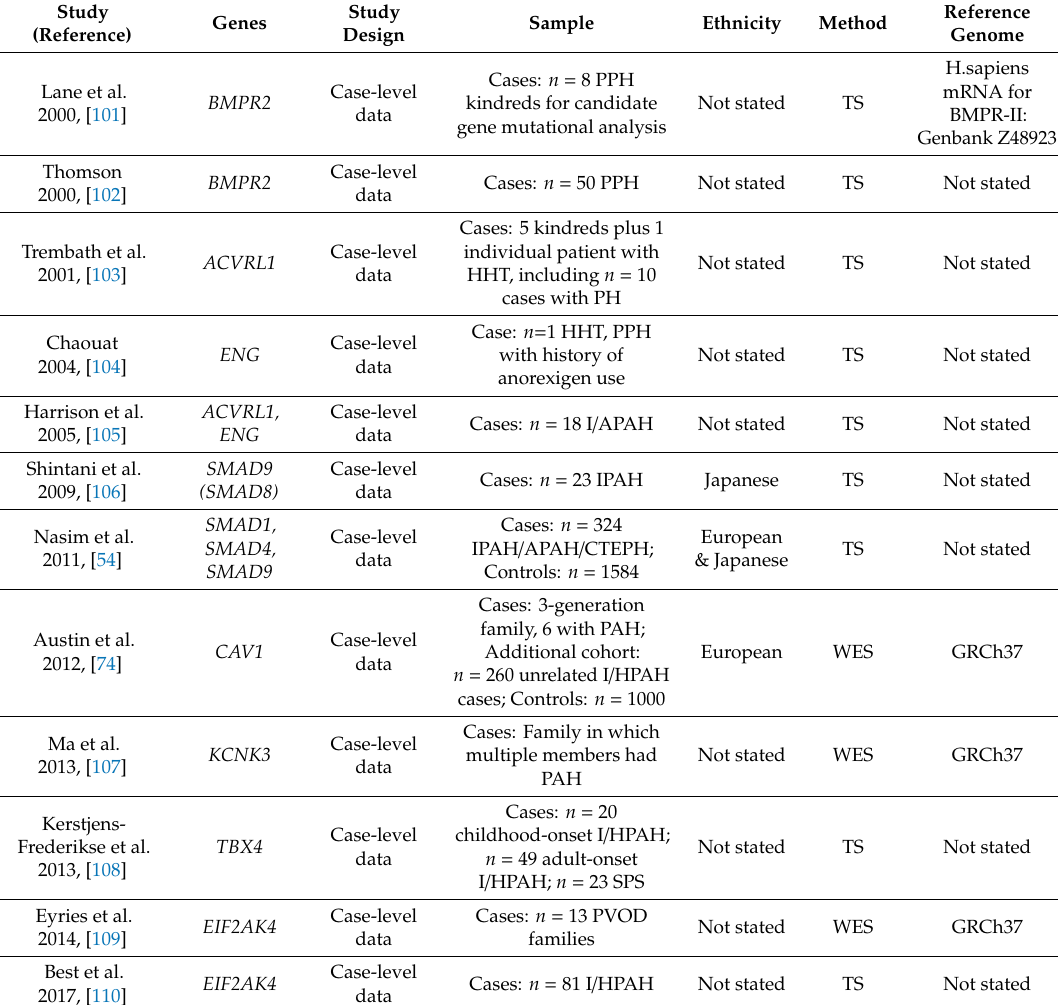
Table 2. Landmark forward genetics studies in Group 1 PAH. Abbreviations: BMPR2